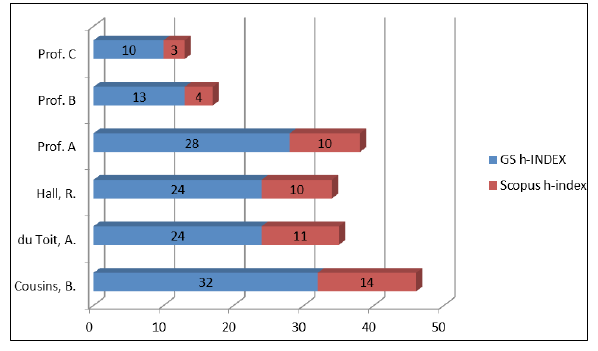
Figure 3: Comparative h -indices of researchers from Google Scholar (GS) and Scopus.